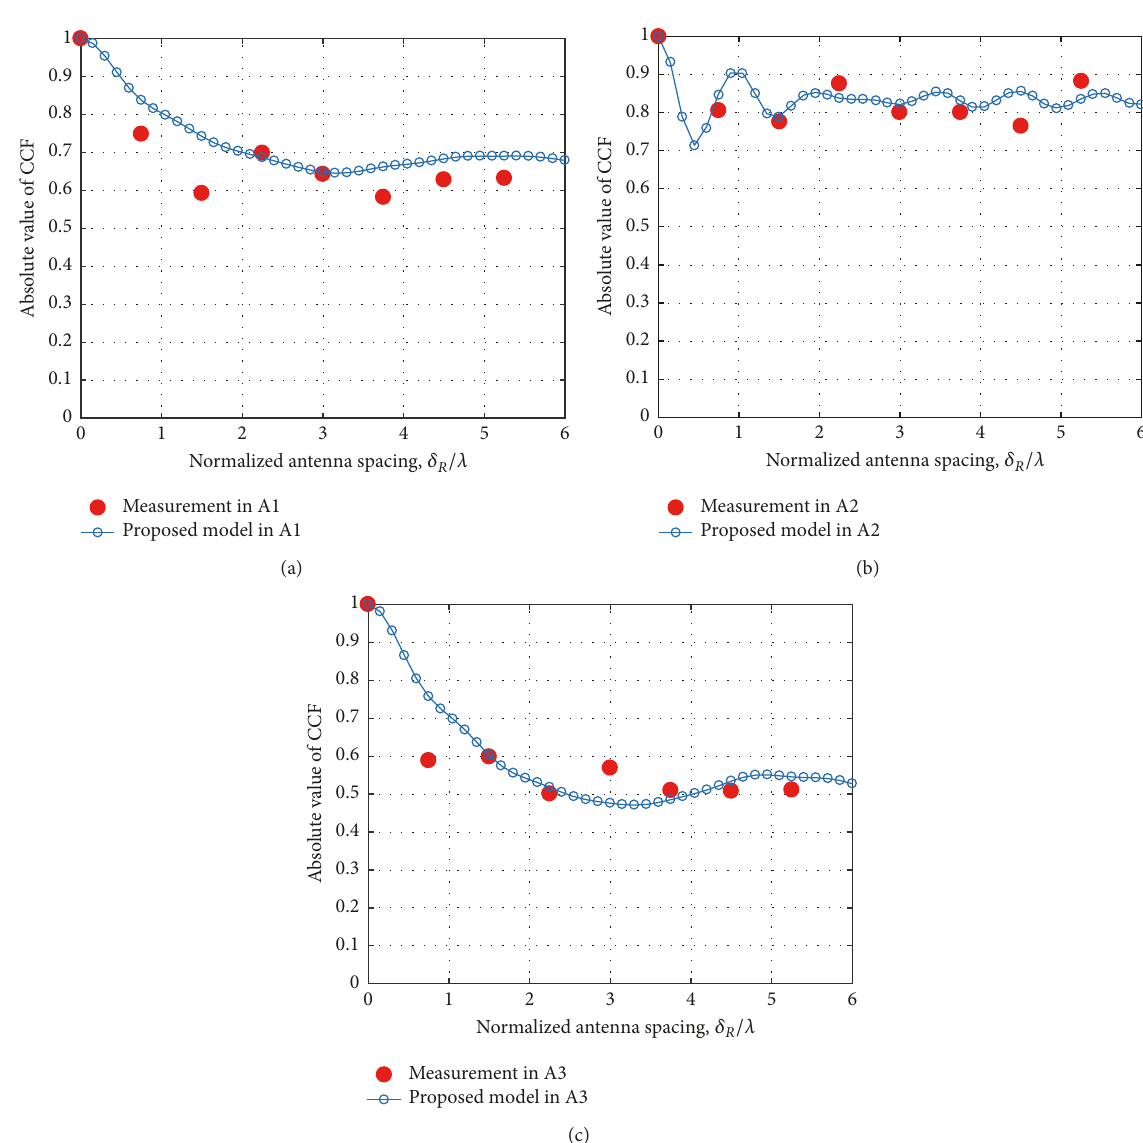
Figure 12: Comparison of the spatial CCF with various receive antenna spacings in (a) A1 area, (b) A2 area, and (c) A3